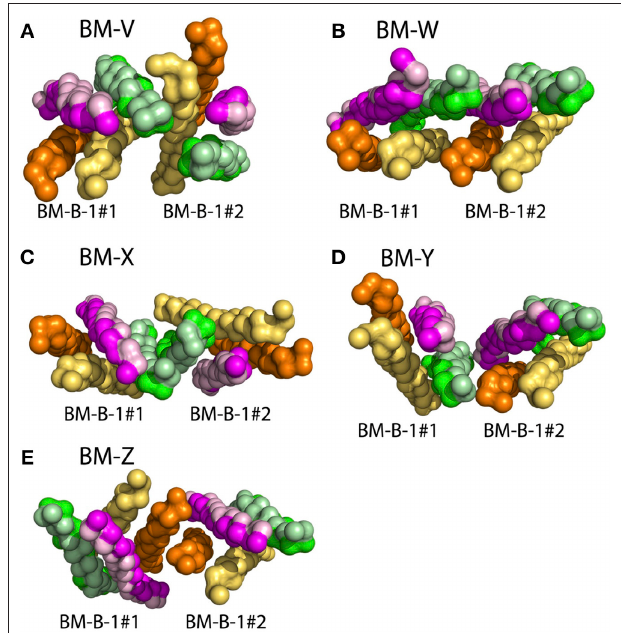
FIGURE 9 | BCR TMD dimer structures as obtained from spontaneous assembly of two BCR TMDs (BM-B-1 conformation, see Table 2 , Step 6). The BCRs are colored comparable to Figure 6 , however the TM-C and TM-S sites of mIgM are not highlighted here. (A) BM-V, (B) BM-W, (C) BM-X, (D) BM-B-Y, (E) BM-B-Z conformations. See Figure S10 for orientation analysis and populations of the BCR TMD